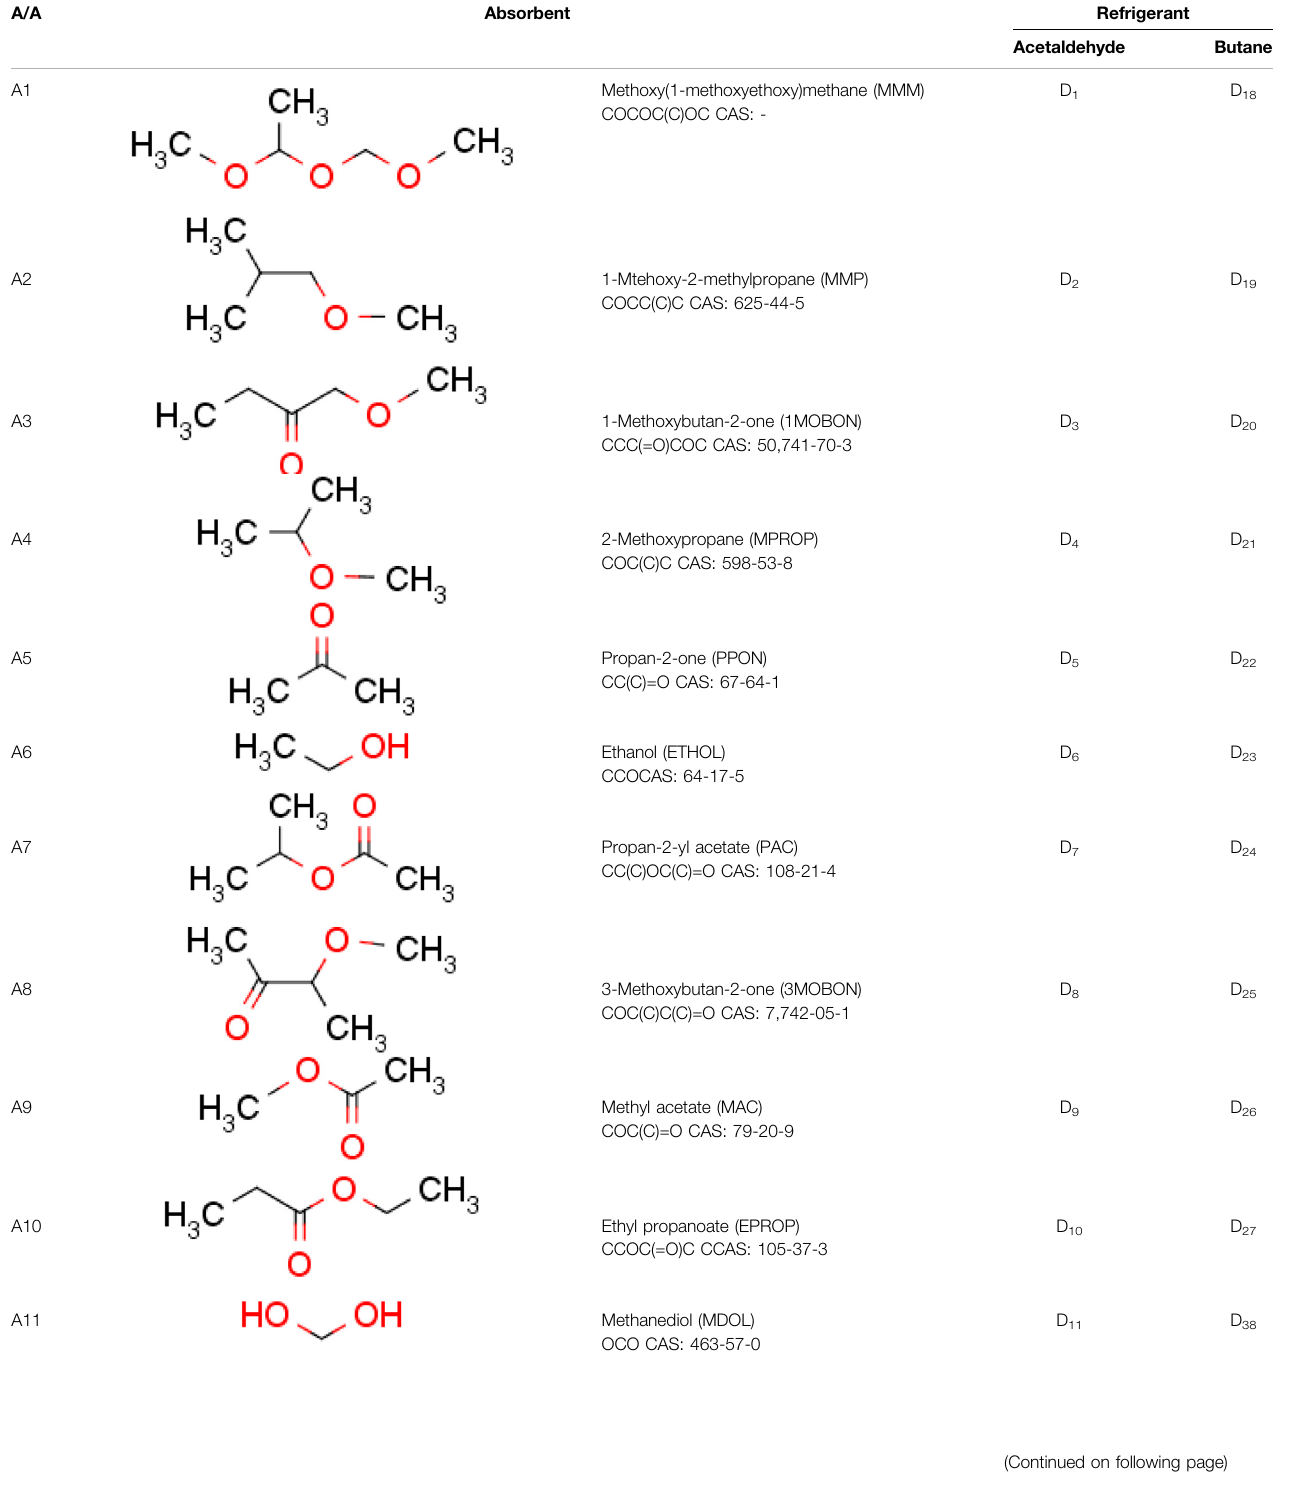
TABLE 3 | Mixtures designed in this work. An abbreviation is used in brackets, after the IUPAC names for each absorbent. Abbreviations with the letter D indicate a mixture formed by one of the refrigerants with each absorbent. For example, D1 is a mixture of Acetaldehyde/MMM.